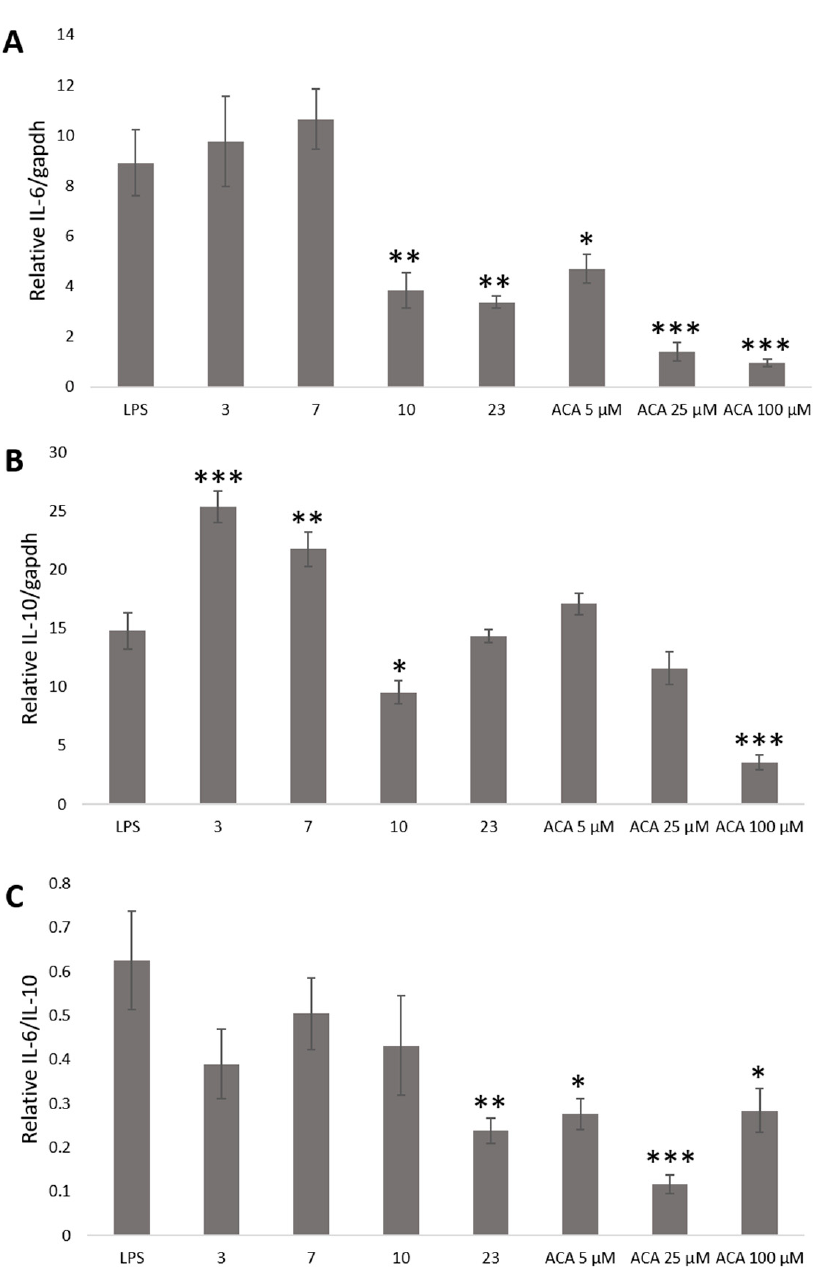
Figure 5. The expression of relative IL-6/gapdh ( A ), IL-10/gapdh ( B ) and IL-6/IL-10 ( C ) by microplate luminometer at 8 h. Stable cells were treated with crude ethanol extracts from nutmeg (3), oregano (7), laurel (10), and long pepper (23) at 75 µg/mL and 1 ′ S-1 ′ -Acetoxychavicol acetate (ACA) at 5, 25, 100 µM from greater galangal and LPS at 100 ng/mL. Each value represents the mean ± SD ( n = 4). * p < 0.05, ** p < 0.01, *** p < 0.001 versus the LPS group.